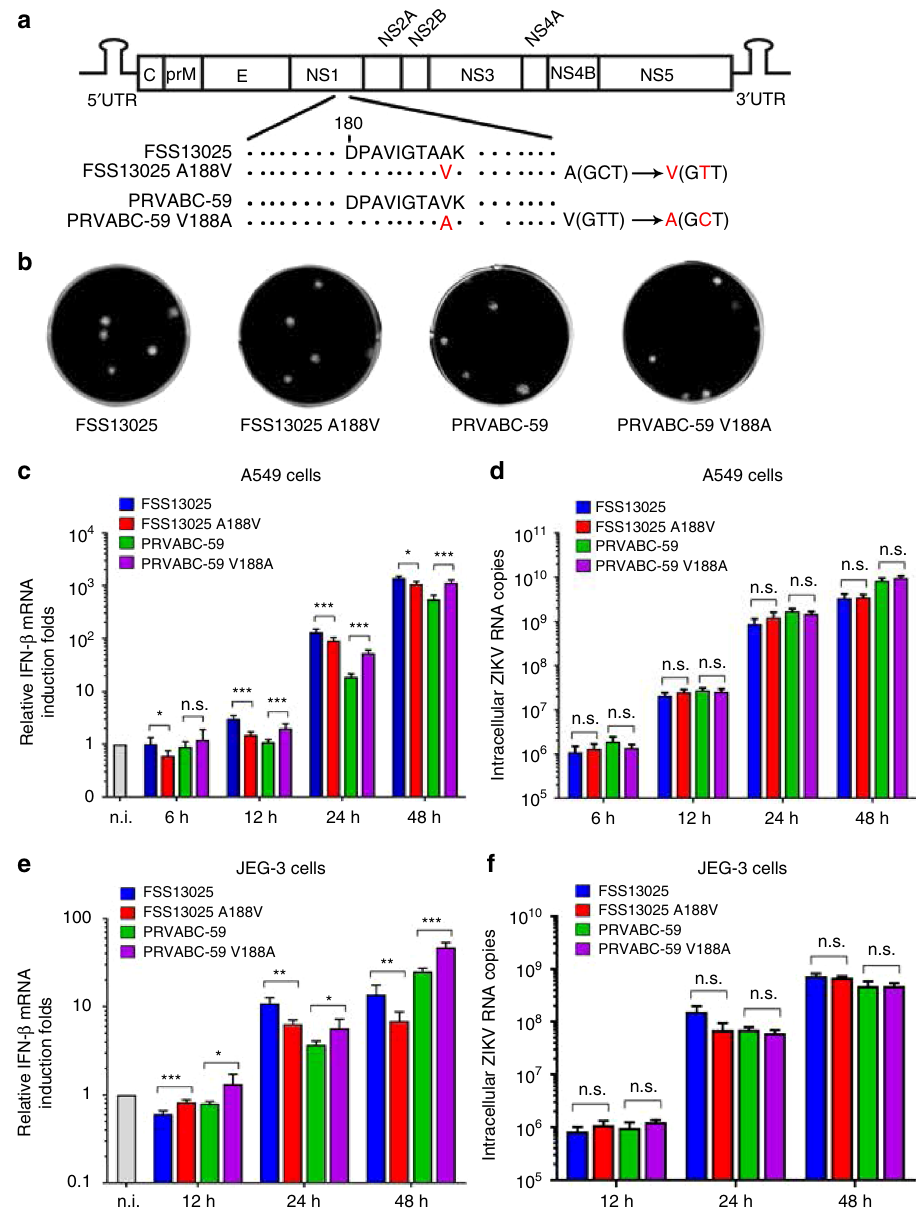
Fig. 5 The identity of amino acid 188 of NS1 modulates IFN- β production during ZIKV infection of human cell lines. a Schematics of construction of ZIKV WT and corresponding NS1 mutant viruses. Codons for 188-Ala and 188-Val of NS1 are indicated. b Plaque morphology of recombinant viruses: FSS13025 WT, FSS13025 A188V mutant, PRVABC-59 WT, and PRVABC-59 V188A mutant. c – f IFN- β production of A549 cells ( c ) or JEG-3 cells ( e ) in response to ZIKV infection. A549 cells were infected with FSS13025 WT, FSS13025 A188V, PRVABC-59 WT, or PRVABC-59 V188A at an MOI of 0.5. Cells were harvested from 6 to 48 h p.i., total intracellular RNA was isolated, and IFN- β mRNA expression levels were quanti fi ed by qRT-PCR. GAPDH was used as a housekeeping gene for normalization. The mRNA levels are shown as fold induction over mock samples. d Intracellular viral RNA copies in A549 cells. f Intracellular viral RNA copies in JEG-3 cells. Error bars indicate standard deviations from three independent experiments. Statistical values were analyzed by unpaired Student ’ s t- test, * P < 0.05, ** P < 0.01, *** P < 0.001, or no signi fi cance